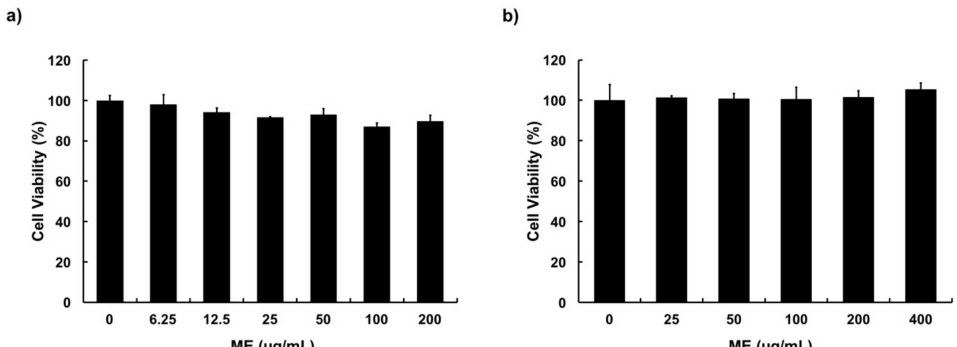
Figure 2. Cytotoxicity of moringa extract (ME) in MAC-T cells. ( a ) MTT assay and ( b ) trypan blue exclusion assay were used to determine the viability of MAC-T cells. Cells were treated with various concentrations (0–400 µ g / mL) of ME for 24 h. Values represent means ± SEM ( n =